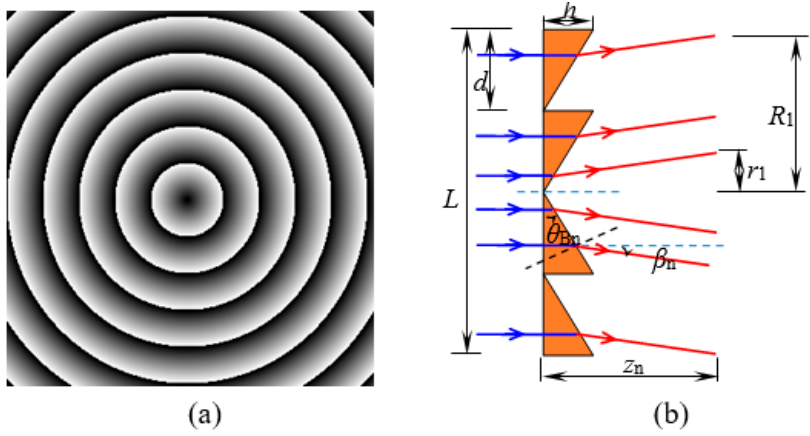
Figure 4. ( a ) The hologram for realizing the negative axicon, and ( b ) its central profile.